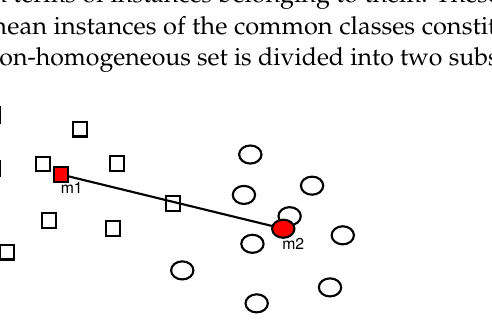
Figure 2. The RSP3-M and RSP3E-M algorithms divide a subset according to the means of the two most common classes in the subset m 1 and m 2.